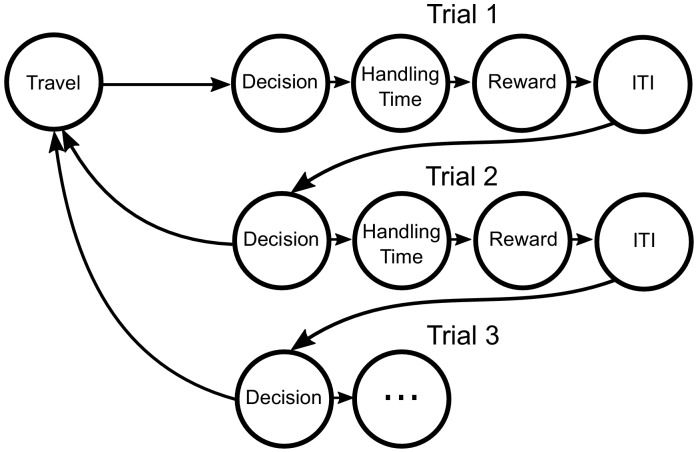
State space diagram of the foraging task.State space diagram for the semi-markov model of the foraging task. Decisions to stay vs. leave are made in Decision states. A decision to stay causes a transition to the handling time, then reward, ITI, and to the Decision state on the next trial. Reward is delivered uniformly throughout time spent in the each reward state. Reward depletion is achieved via shorter time spent in the reward state (resulting in longer stay in the ITI state). A decision to leave causes a transition to the Travel state, then to the first trial of the patch.